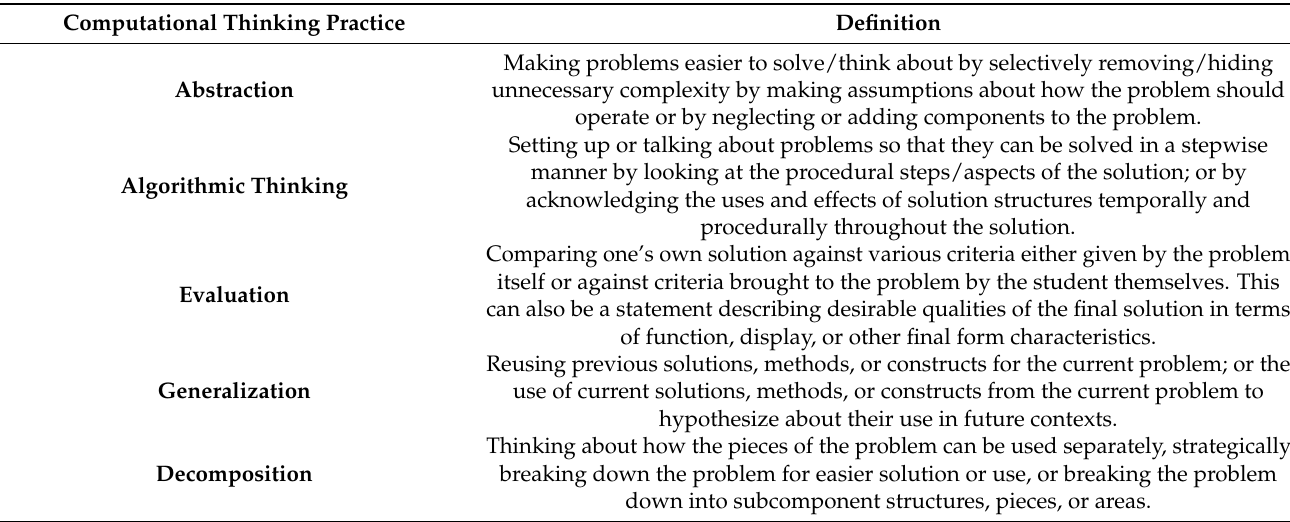
Table 2. Practices within computational thinking (CT) and definitions from the literature